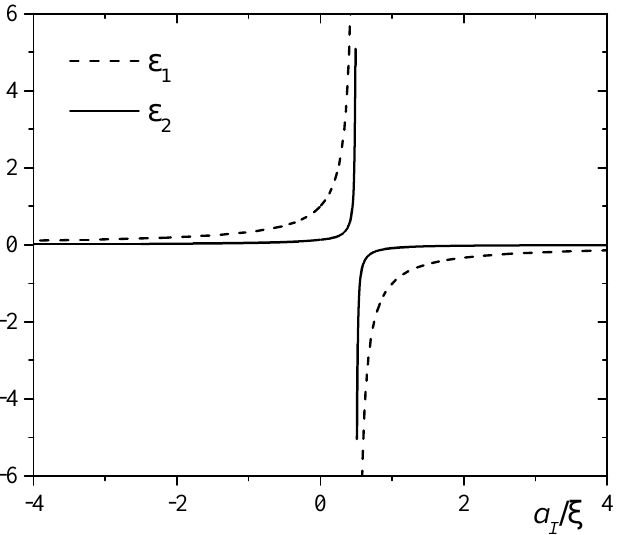
(cid:16) (cid:17) a I ; ∞ determining the one-impurity energy in 3D dilute ξ